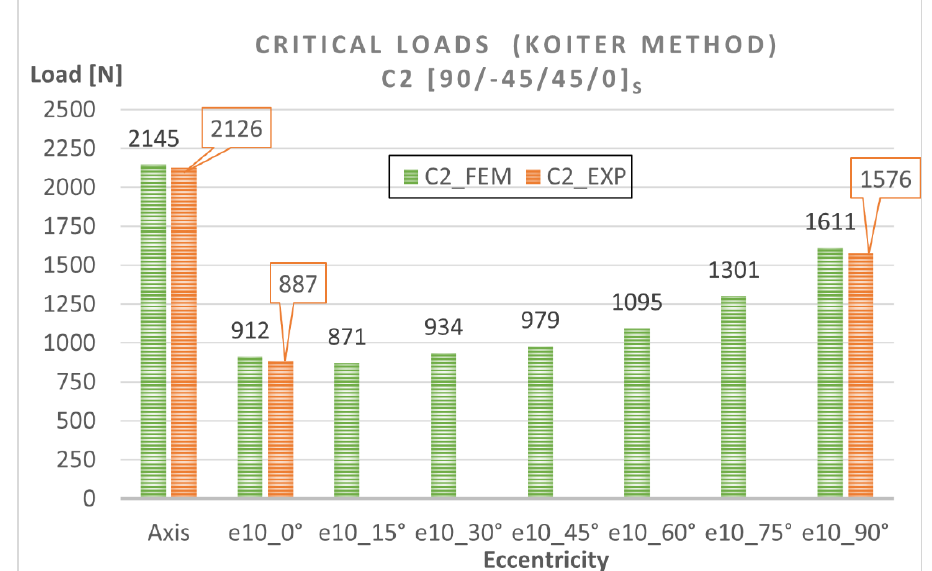
Figure 15. Eccentricity versus critical load for C2 [90/ − 45/45/0] s